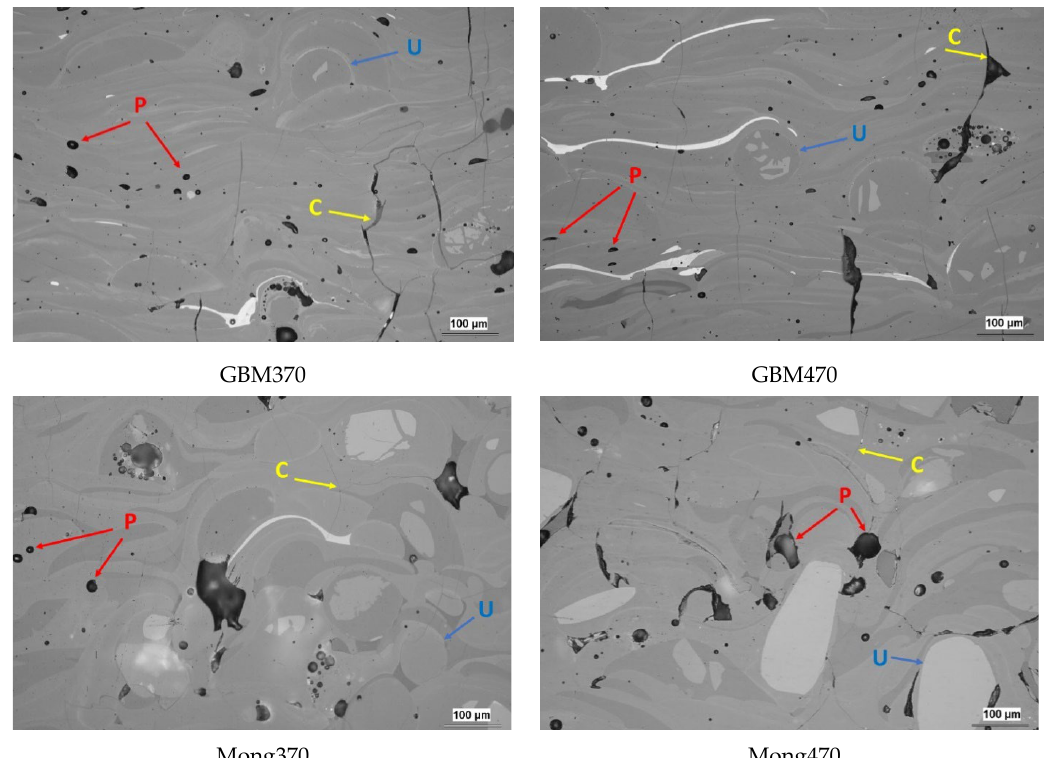
Figure 2. Light micrographs on cross sections of coatings. The powders for spraying came from different mines in Mongolia (label Mong) and in the Czech Republic (label GBM). The number indicates spray distance in mm.